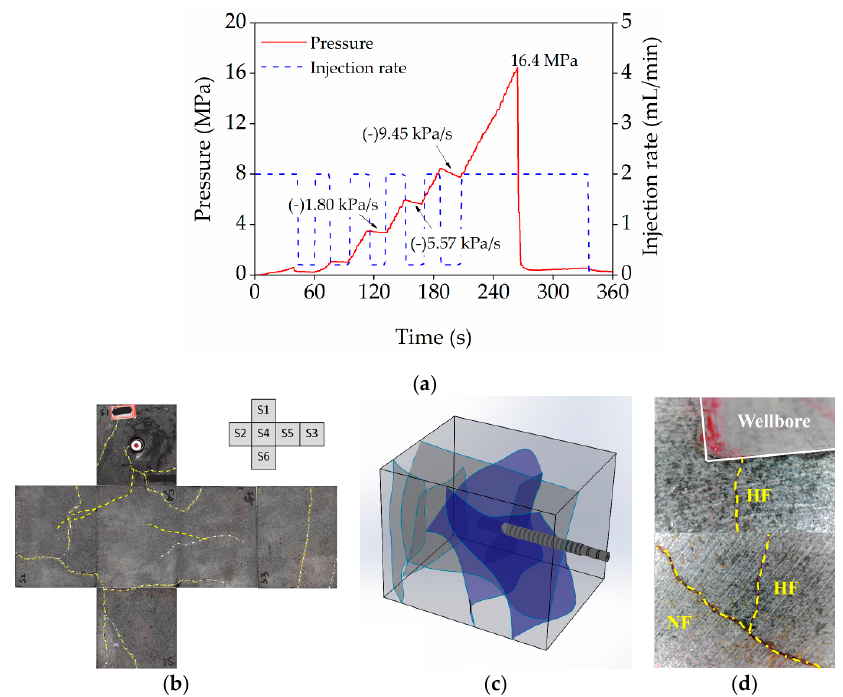
Figure 13. Fracture details of specimen No. 8: ( a ) Pressure curve, ( b ) distribution on the surface, ( c ) internal reconstruction, and ( d ) microscopy image.